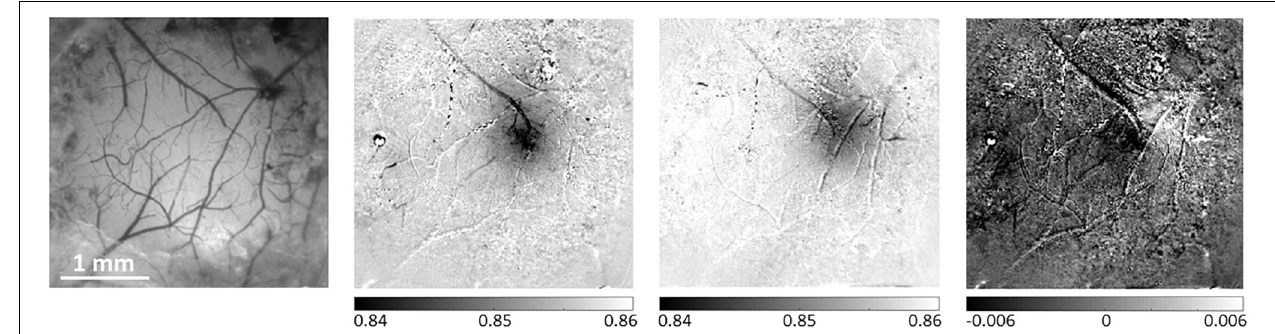
FIGURE 4 | Differential analysis of evoked hemodynamic responses improves spatial contrast and definition of a single barrel activation area. The left-most panel presents a reference image taken under illumination wavelength of 530 nm, showing the pial vessel topography. The second panel shows the hemodynamic response to a single-whisker stimulation of the B1 whisker, calculated as the division of the images acquired during stimulation trials by the images acquired during control/no stimulation trials. The third panel shows a similar result for the Alpha whisker. In the third panel, the differential analysis of these two neighboring whiskers’ responses improves the spatial discrimination between the two individual but partially overlapping responses. The grayscale applied to all images represents the same range of relative responses. The scale bar represents 1